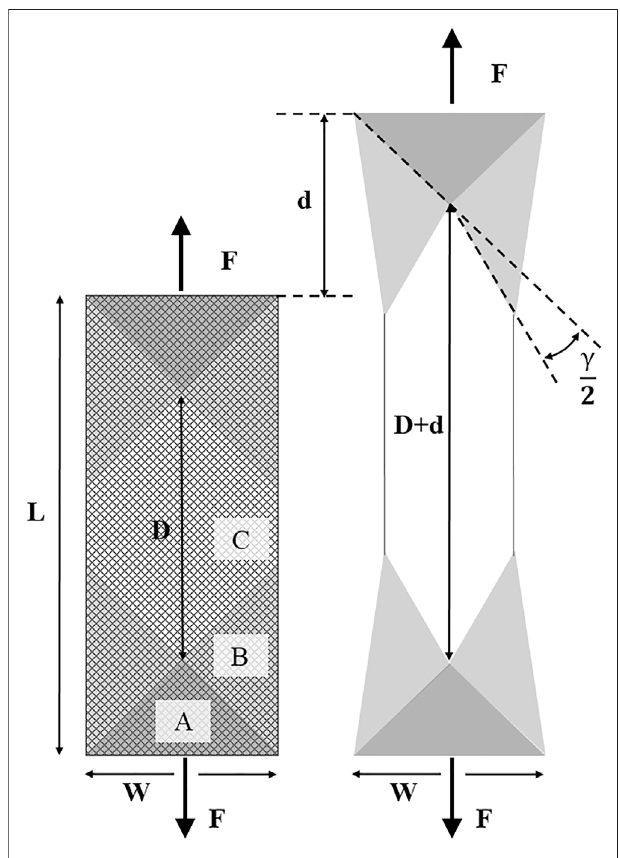
FIGURE 1 | Bias extension test standard